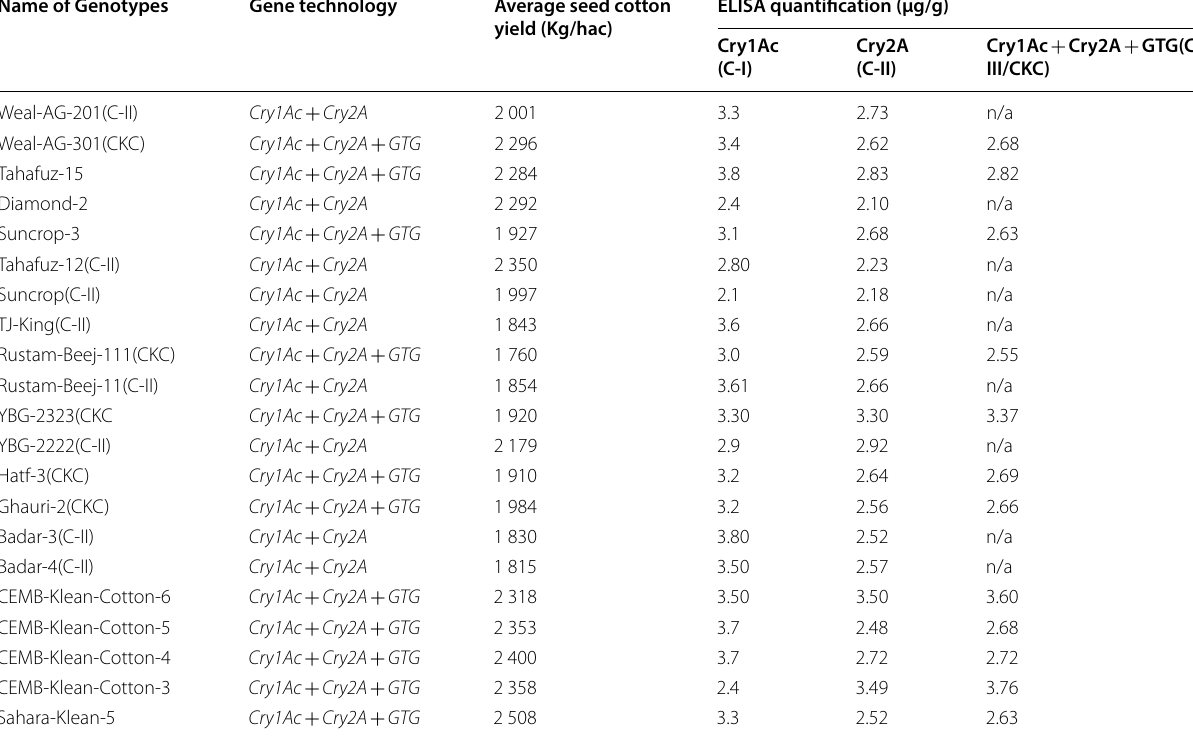
Table 2 Yield and expression of Cry genes in different lines tested in NCVT trial 2018–2019. Source Directorate of Agriculture Research, Pakistan Central Cotton Committee, Multan, Pakistan Name of